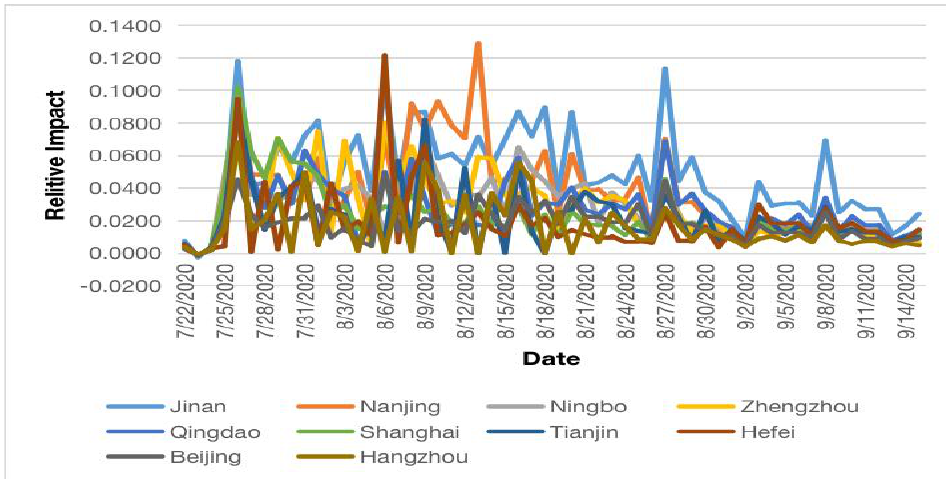
Figure 12. The impact of outbreaks in Dalian on air routes.